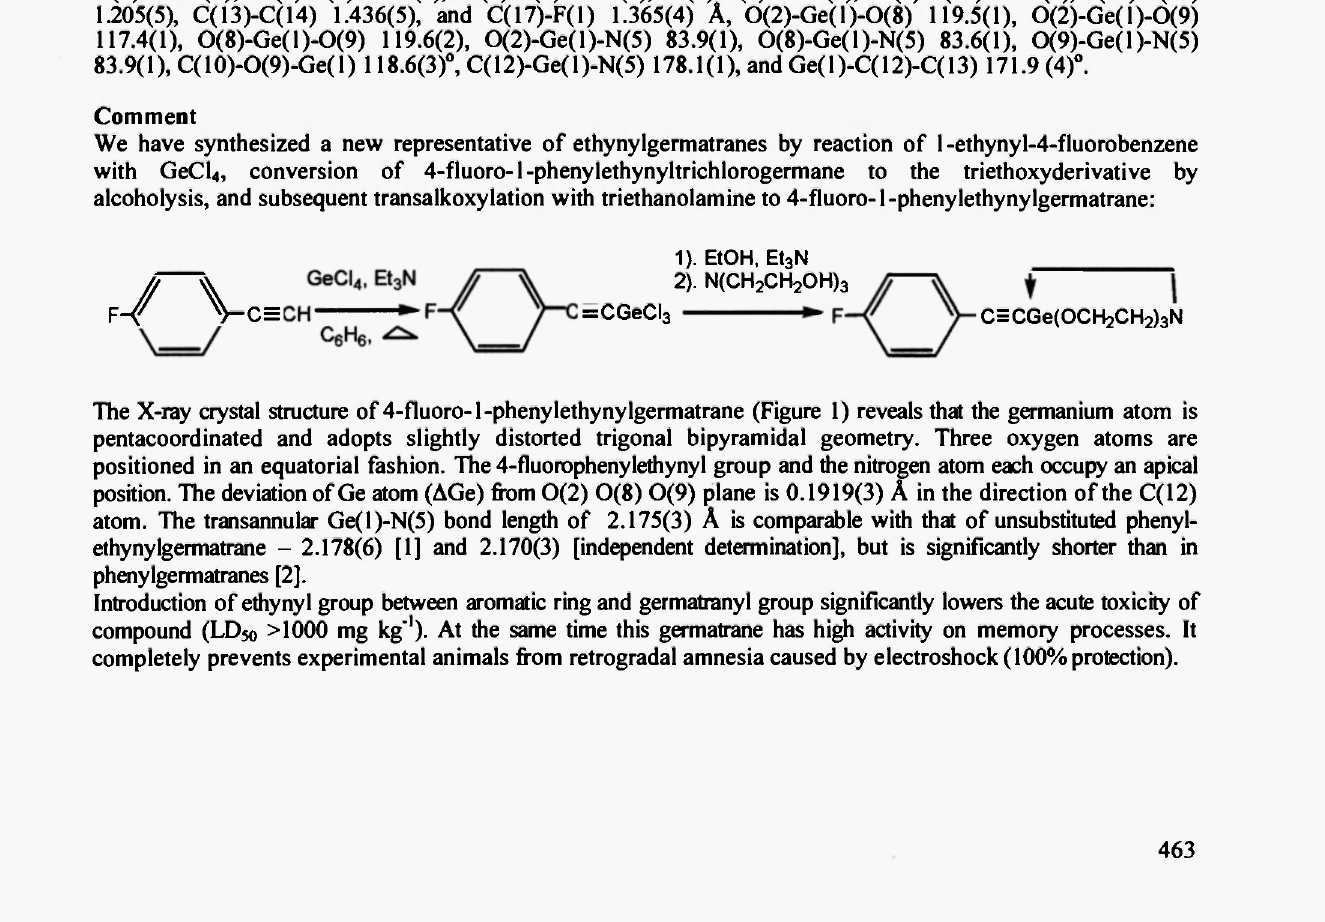
Figure 1. Molecular structure of 4-fluoro-l-phenylethynylgermatrane. Selected geometric parameters: Ge(l)- N(5) 2.175(3), Ge(l)-0(2) 1.788(2), Ge(l)-0(8) 1.787(2), Ge(l)-0(9) 1.779(3), Ge(l)-C(12) 1.926(3), C(12)-C(13) 1.205(5), C(13)-C(14) 1.436(5), and C(17)-F(l) 1.365(4) A, 0(2)-Ge(l)-0(8) 119.5(1), 0(2)-Ge(l)-0(9) 117.4(1), 0(8)-Ge(l)-0(9) 119.6(2), 0(2)-Ge(l)-N(5) 83.9(1), 0(8)-Ge(l)-N(5) 83.6(1), 0(9)-Ge(l)-N(5) 83.9(1), C(10)-0(9)-Ge(l) 118.6(3)°, C(12)-Ge(l)-N(5) 178.1(1), and Ge(l)-C(12)-C(13) 171.9